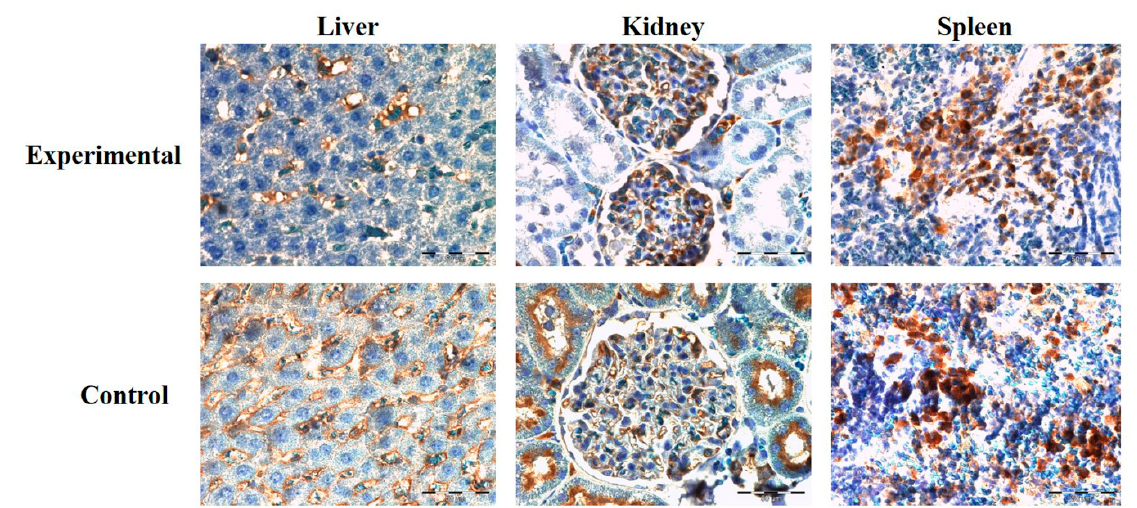
Figure 7. Representative images of CD68 protein expression in rats’ liver, kidney, and spleen tissue sections of experimental and control group, 40 × magnification. Mild expression of CD68+ immunoreactive cells was observed in all groups (brown colored cells).